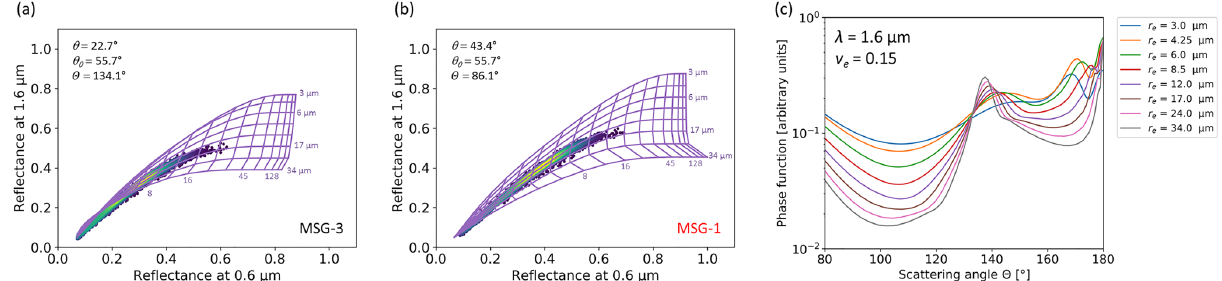
Figure 5. Density plots of (atmospheric-absorption-corrected) reflectance observations from cloudy pixels and corresponding retrieval LUTs for the 15:15UTC time slot in 7 March 2017 over the southeastern Atlantic, shown separately for MSG-3 (a) and MSG-1 (b) . Dark blue to yellow colors show an increase in the density of points. (c) Phase functions at 1.6µm wavelength used in the radiative transfer calculations for the eight r e values of the LUTs, assuming ν e = 0 .